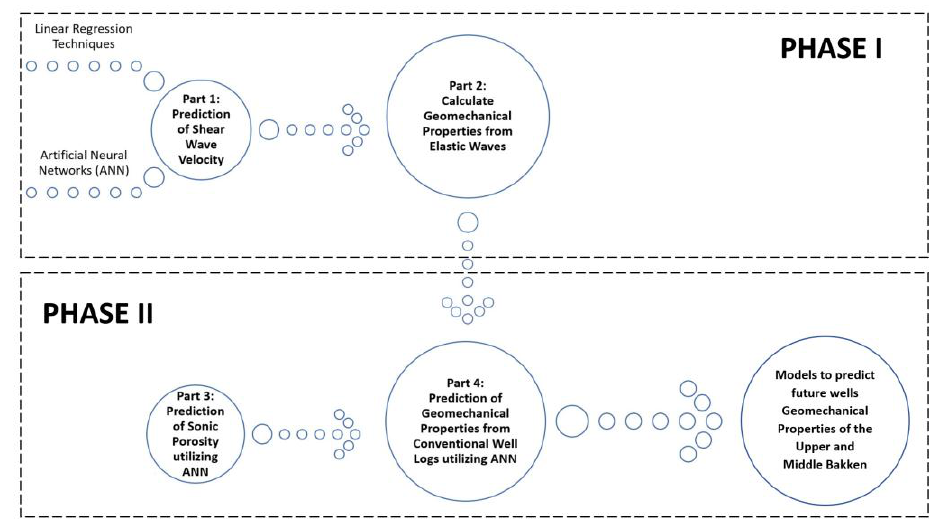
Figure 3. Flowchart with the phases involved in obtaining the various data-driven models.